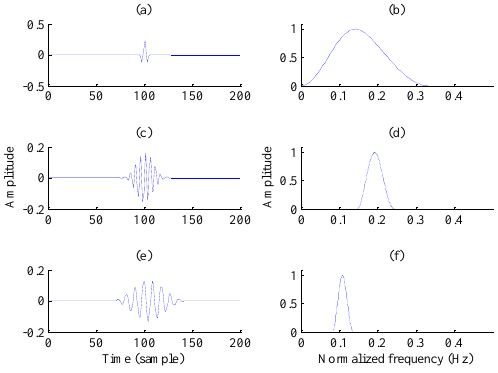
Figure 2. Signals with different Q -factors: ( a , b ) Q = 1; ( c , d ) Q = 4; ( e , f ) Q = 4.